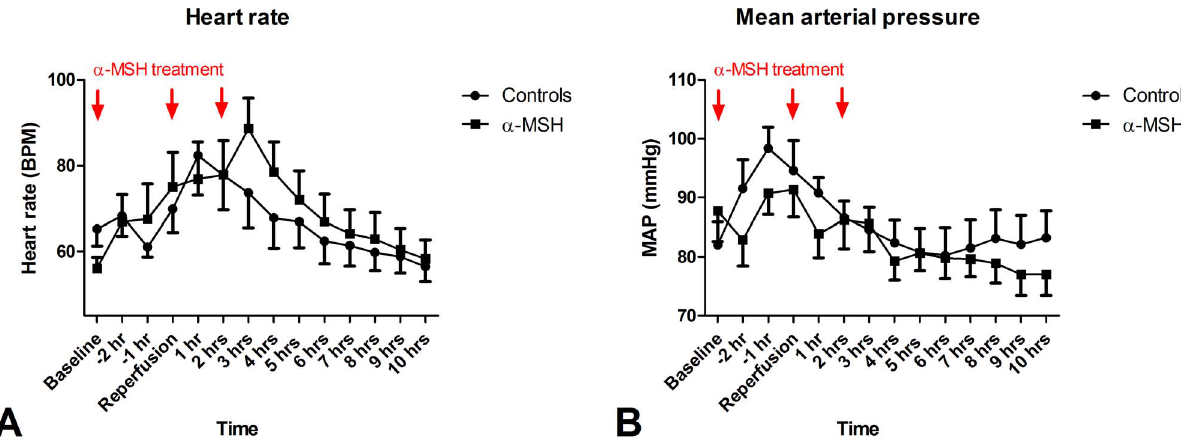
Figure 5. Effect of a -MSH on hemodynamic parameters. a -MSH tended to increase heart rate (Figure 5A) and reduce MAP (Figure 5B) after each dose.